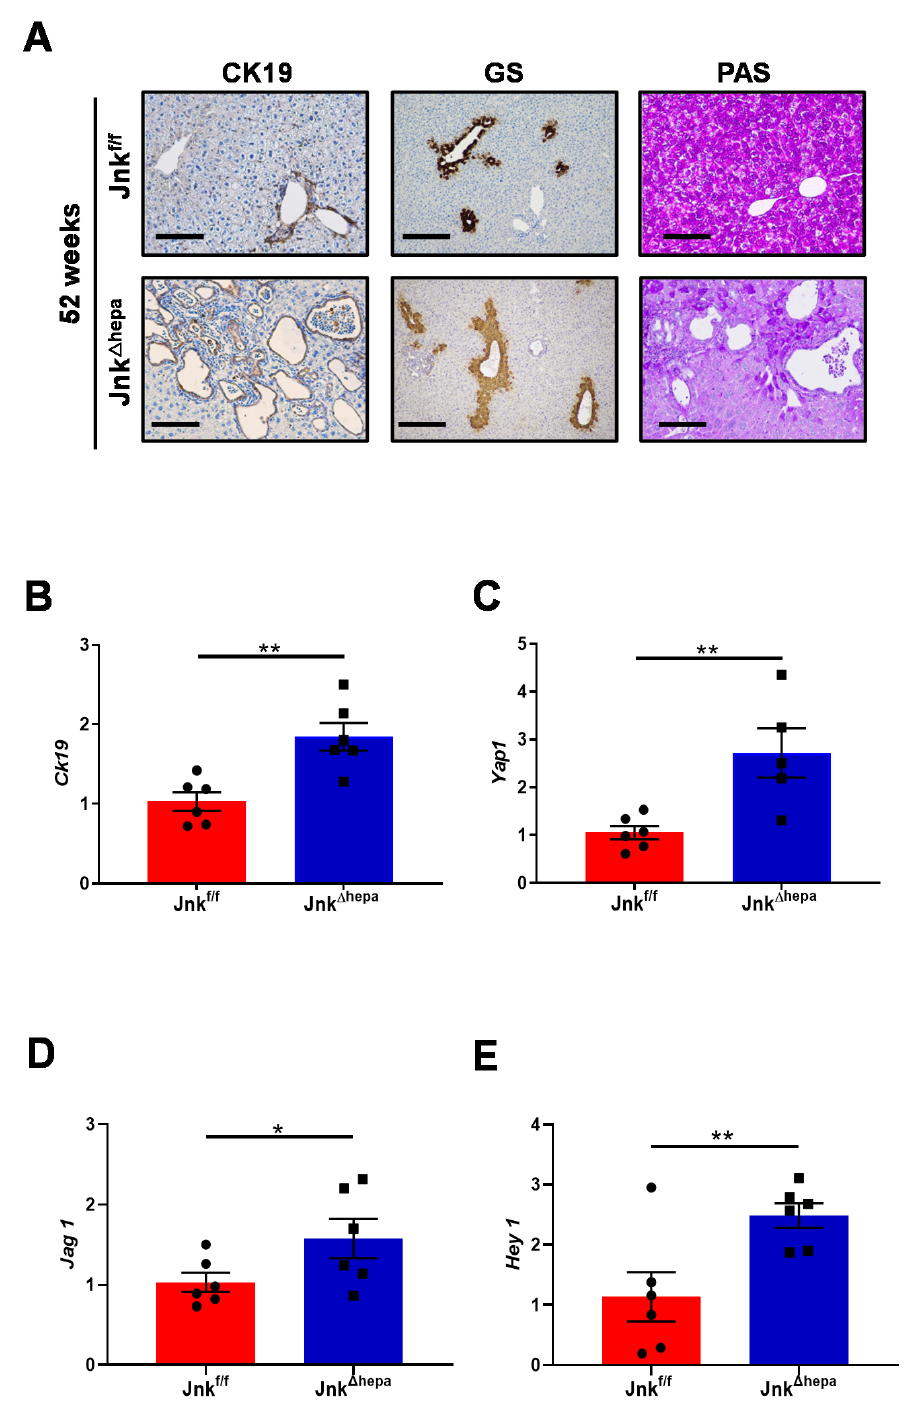
Figure 3. End-stage disease in liver injury of 52-week-old Jnk ∆ hepa mice. ( A ) Expression of CK19 (left panel), Glutamine synthase (GS) and Periodic Acid Schiff (PAS) were performed in paraffin sections from 52-week-old Jnk f/f and Jnk ∆ hepa mice livers. Scale bars, 100 µ m. ( B – E ) Expression of Ck19 , Yap1 , Jag1 and Hey1 was analyzed and graphed. The data were normalized for the amount of Gapdh mRNA in each sample. Data were represented as the mean ± SEM and graphed, separately ( n = 6 mice per group, * p < 0.05; ** p < 0.01).